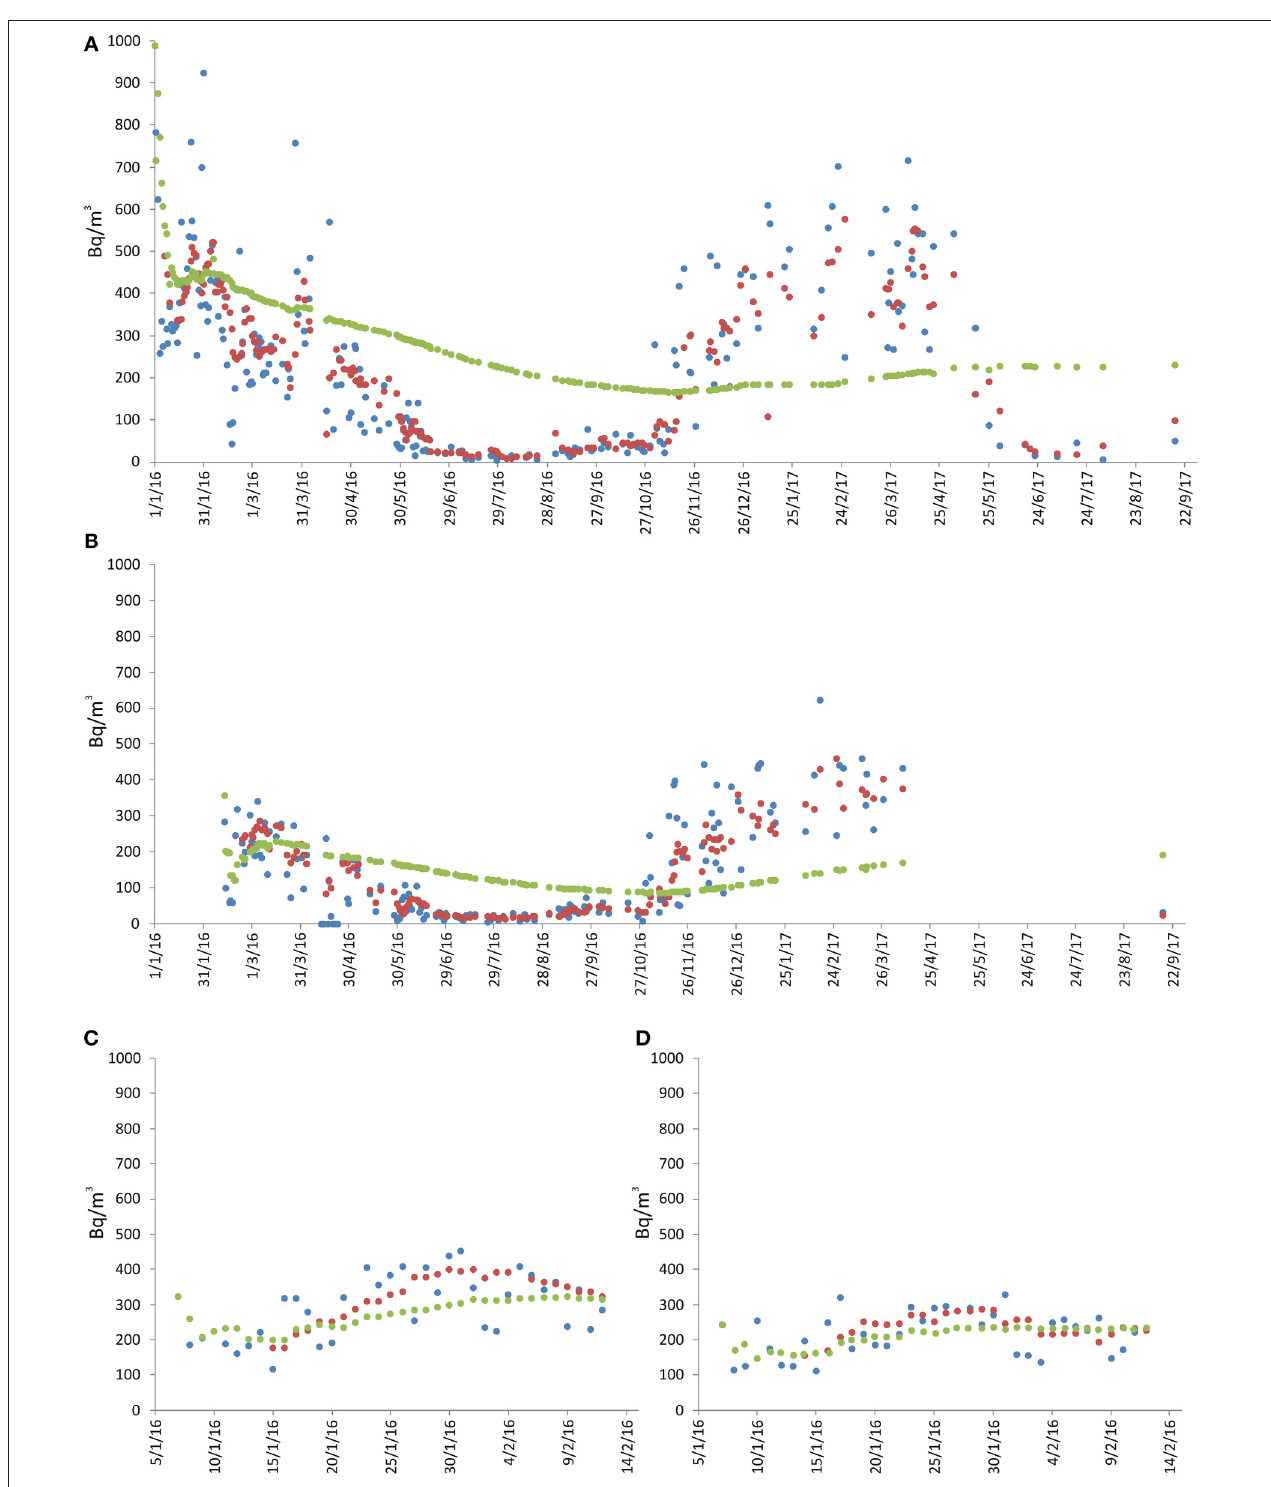
FIGURE 6 | Radon measurements recorded in the Aci Catena municipality, at location 4 [see Figure 1 ; (A) = sensor 5, (B) = sensor 6, (C) = sensor 7, (D) = sensor 8]. Radon concentration are presented as daily (blue line), weekly (red) and long-term (green) averages. No data interruption occurred during the acquisition period. The discontinuities of the green line (long-term average) indicate only discontinuity in the data annotation. See text for details.